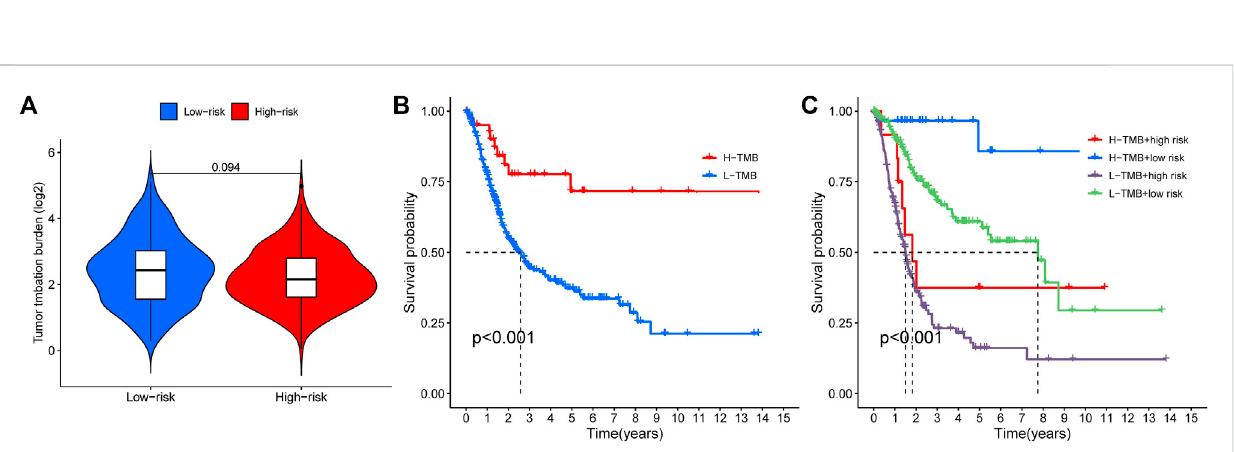
FIGURE 8 Tumor mutation burden and survival analysis (A) TMB comparison between low- and high-risk groups (B) Kaplan-Meier curves for high- and low- TMBgroups (C) SubgroupanalysesforKaplan-Meiercurvesofpatientsstrati fi edbyTMBandriskscores.*means p < 0.05,**means p < 0.01,***means p <